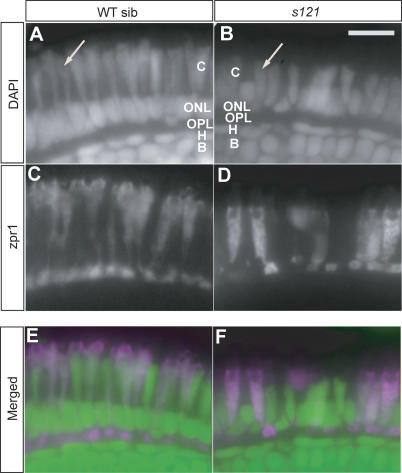
Example of a Mutant with Abnormal Morphology of Cone PhotoreceptorsPhotoreceptors in a retinal section stained with DAPI (A and B) and a marker for double cones, zpr1 (C and D) at 7 dpf in WT larva (A, C, and E) and yois121 mutant retina (B, D, and F). Merged images of DAPI (in green) and zpr1 (in magenta) are also shown (E and F). Both zpr1-positive and zpr1-negative cone photoreceptors in the mutant are “stumpy” when compared to those in the control retina (arrows). B, bipolar cells; C, cone photoreceptor cells; H, horizontal cells; ONL, outer nuclear layer; OPL, outer plexiform layer. Scale bar is 10 μm.